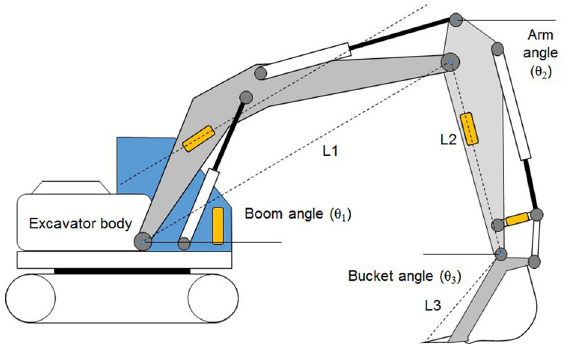
Fig. 3. Installation of IMU sensors on the excavator